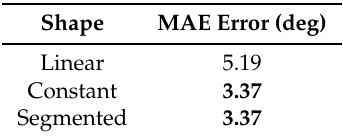
Table 1. Comparison of the proposed filter with different correction function shapes.